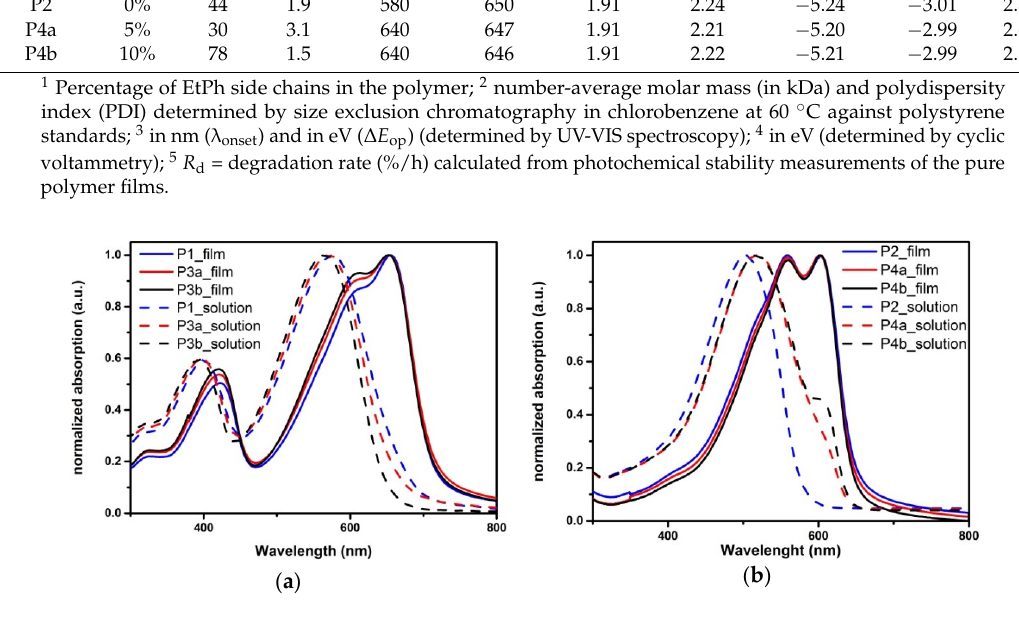
Figure 3. Normalized UV ‐ VIS absorption spectra for the benzo[ c ][1,2,5]thiadiazole (BT) ‐ ( a ) and thiazolo[5,4 ‐ d ]thiazole (TzTz) ‐ ( b ) based polymer series.